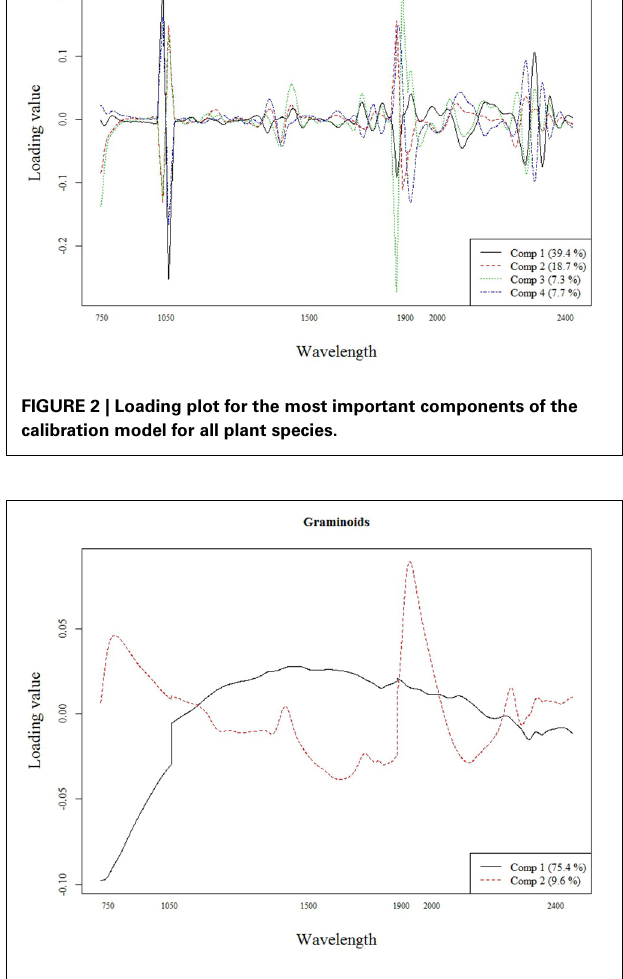
FIGURE 3 | Loading plot for the most important components of the calibration model for the graminoids.